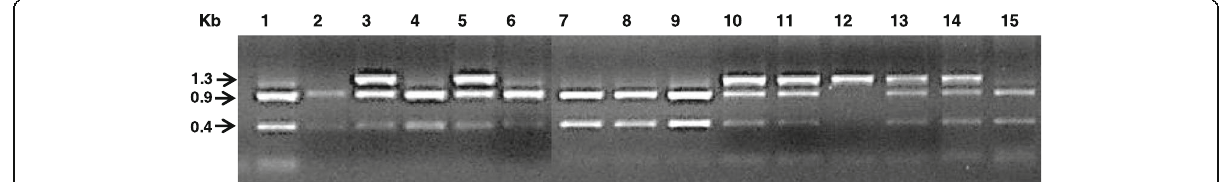
Fig. 2 Representative gel of the polymorphism pattern resulting from the restriction with Pvu IIof amplified samples for the estrogen receptor alpha. Samples with one band only indicate a wild profile (~ 1300 pb, eg., lane 12), whereas samples with three bands (~ 1300, ~ 900, and ~400pb, eg., lanes 3 and 5) and with two bands (~ 900 and ~400pb, eg., lanes 7 and 9) indicate the heterozygous and homozygous profiles for mutation, respectively. The arrows point to the migration of each of the expected